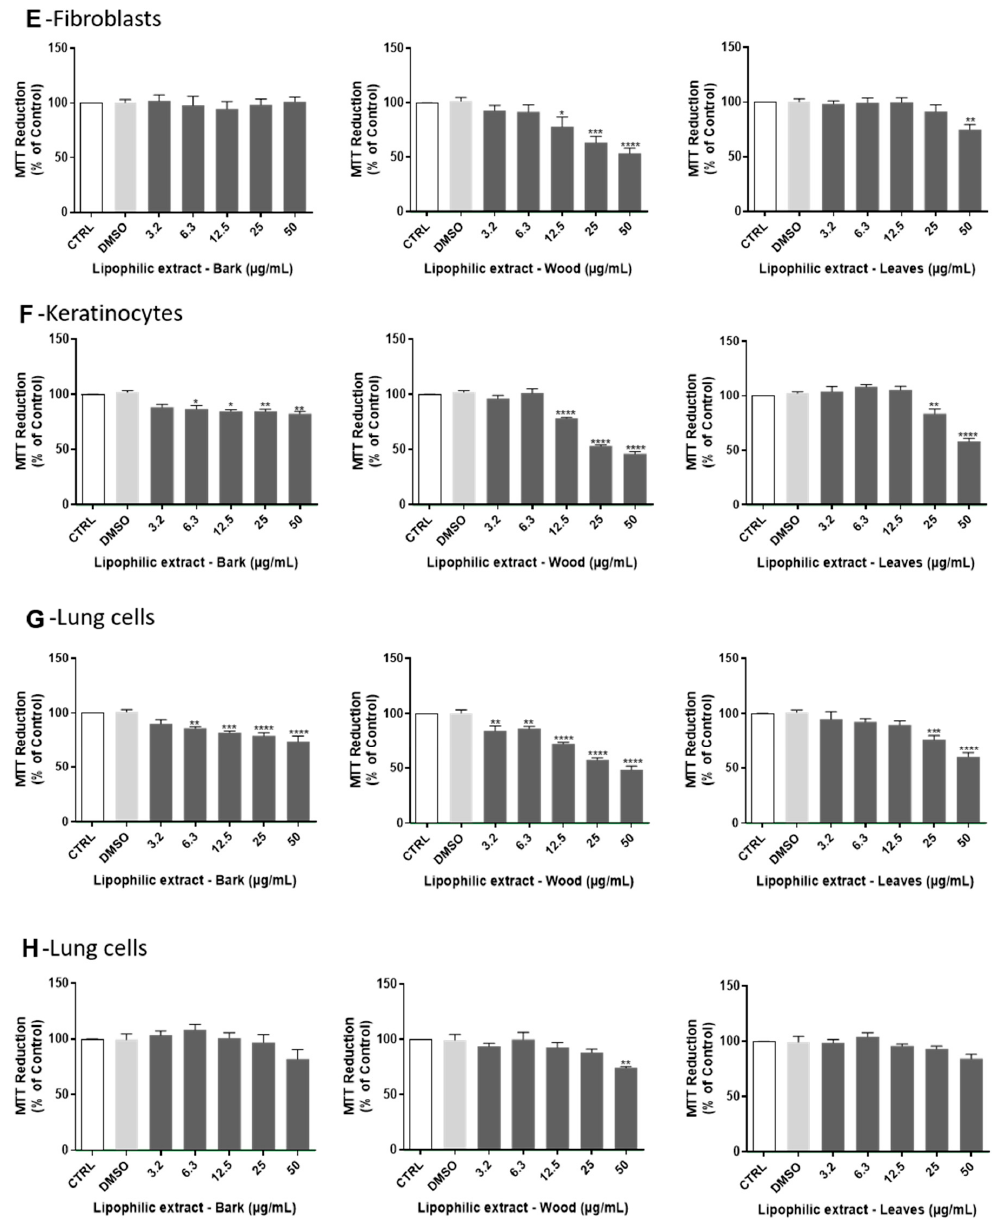
Figure 3. Effect of lipophilic extracts from A. dealbata on non-differentiated ( A ) and differentiated ( B ) neuronal N2A, microglia BV-2 ( C ), macrophages Raw 264.7 ( D ), fibroblasts NIH/3T3 ( E ), keratinocytes HaCaT ( F ), lung A549 ( G ) and liver hepatocyte HepG2 ( H ) cells viability. Cells were treated for 24 h at 37 °C with concentrations of 0–50 µg mL -1 of lipophilic extracts obtained from bark, wood and leaves of A. dealbata and then viability was evaluated by the MTT assay. The results expressed as percentage (%) of control represent the mean ± SEM of at least 3 independent experiments performed in triplicate. Statistical analysis was made by one-way analysis of variance (ANOVA) followed by Dunnett’s multiple comparison test. * p < 0.05, ** p < 0.01, *** p < 0.001, **** p < 0.0001 significantly different compared to control .